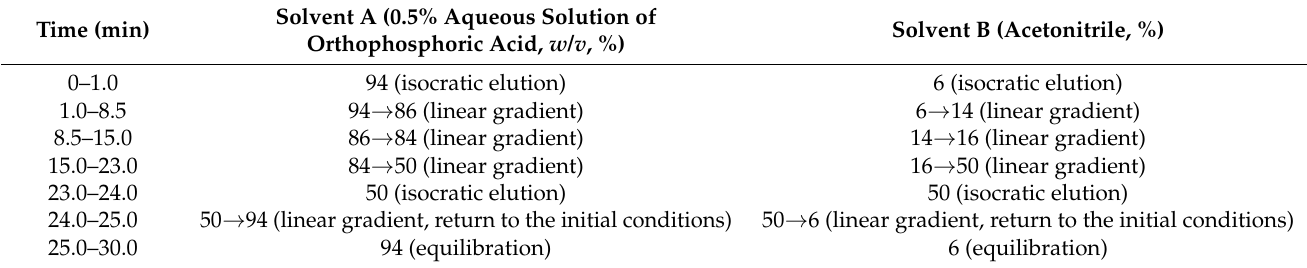
Table 3. The optimised elution